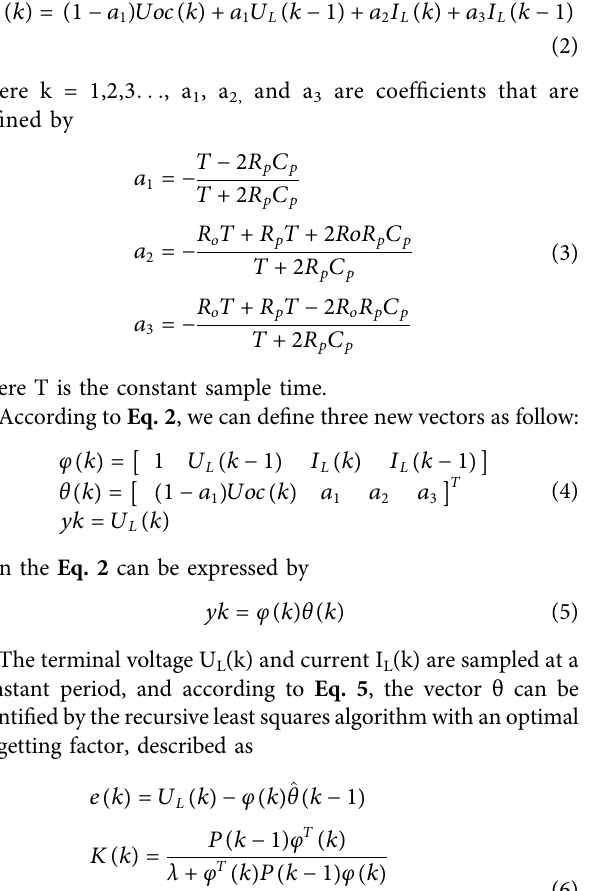
FIGURE 3 | Schematic of the Thevenin model.